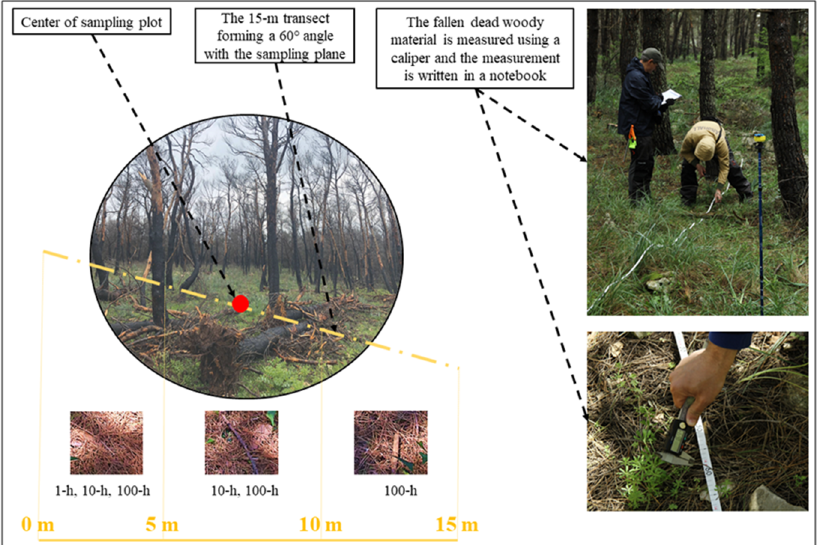
Figure 2. Field sampling protocol. Example of a field plot with a schematic transect ( left ). Operators measuring dead woody material with a caliper during a field survey campaign ( right ).